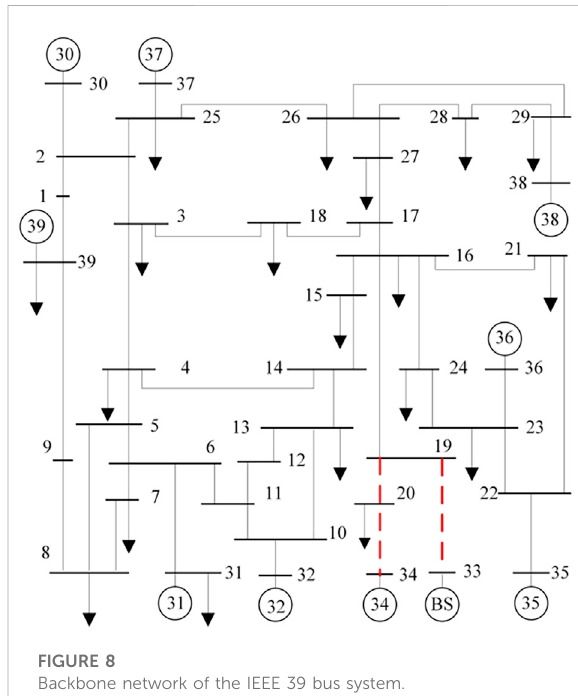
FIGURE 8 Backbone network of the IEEE 39 bus